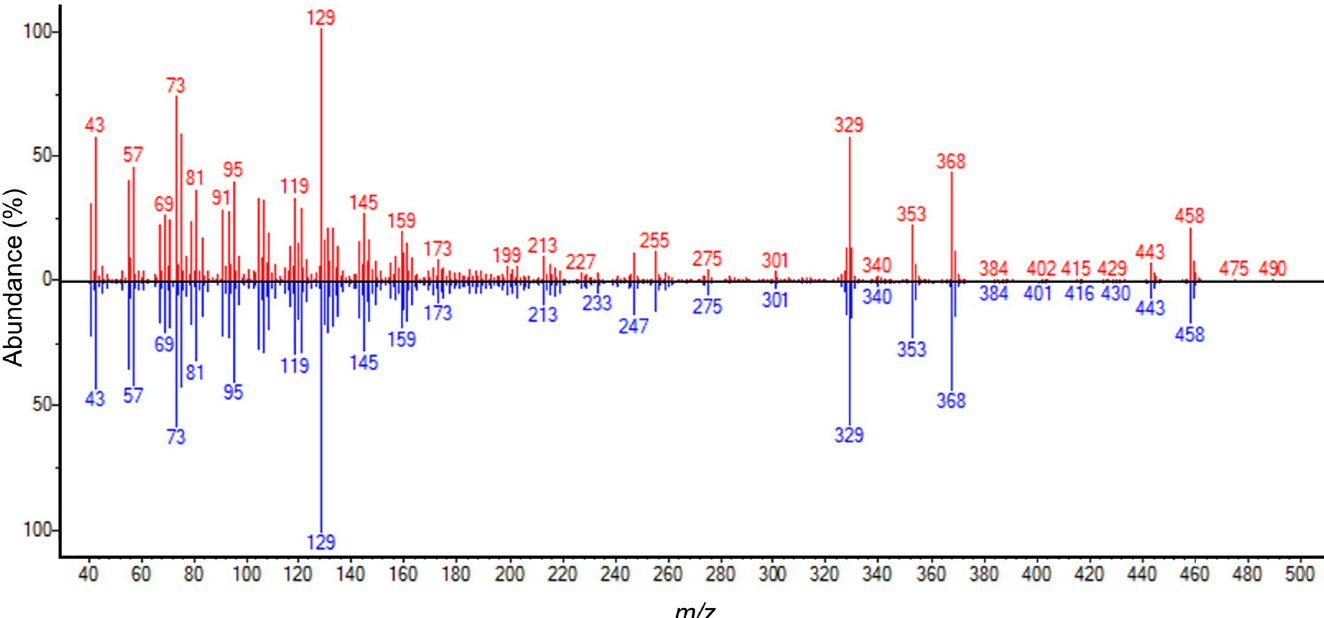
Fig 4. Representative GC–MS spectrum of trimethylsilyl-derivatized cholesterol. Red, MS spectrum of trimethylsilyl-derivatized cholesterol from serum of ovariectomized rat; blue, spectrum from GC–MS NIST library.